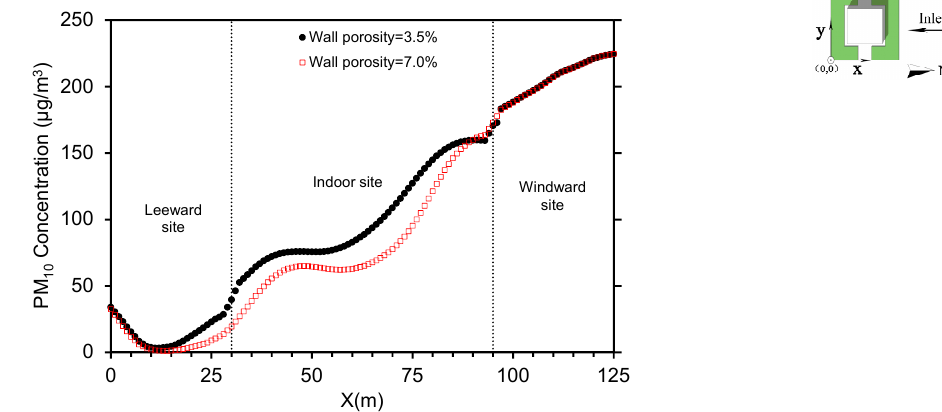
Figure 10. Relationship between oncoming wind speed and average indoor particle concentrations (wall porosity = 3.5%).